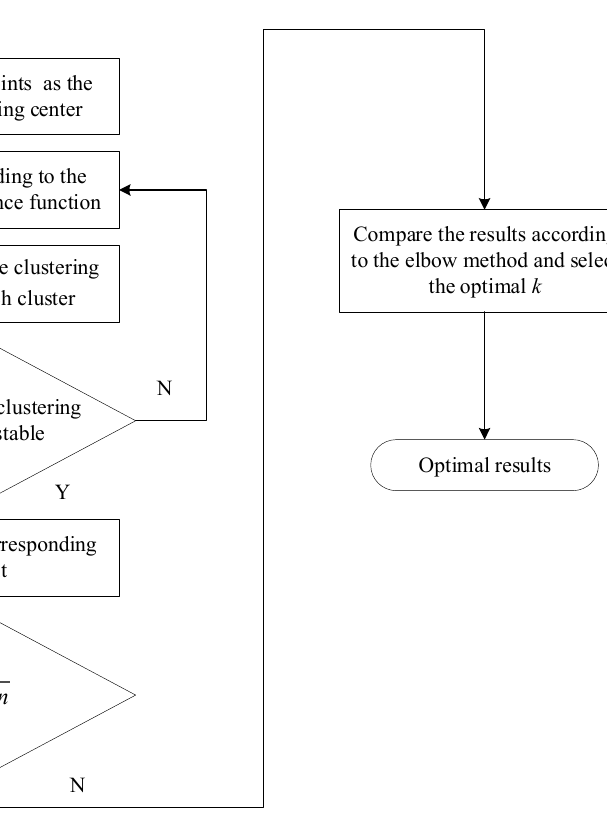
Figure 2. The flow chart of the clustering algorithm.